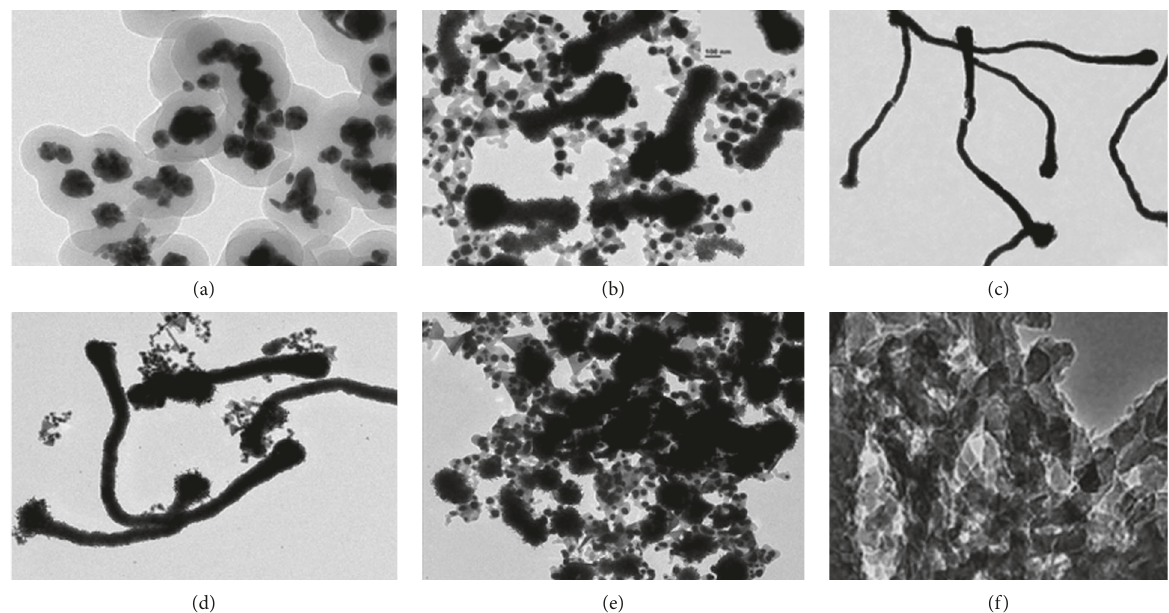
Figure 2: Transmission electron microscopic images of polyaniline samples at different concentrations (refer to Table